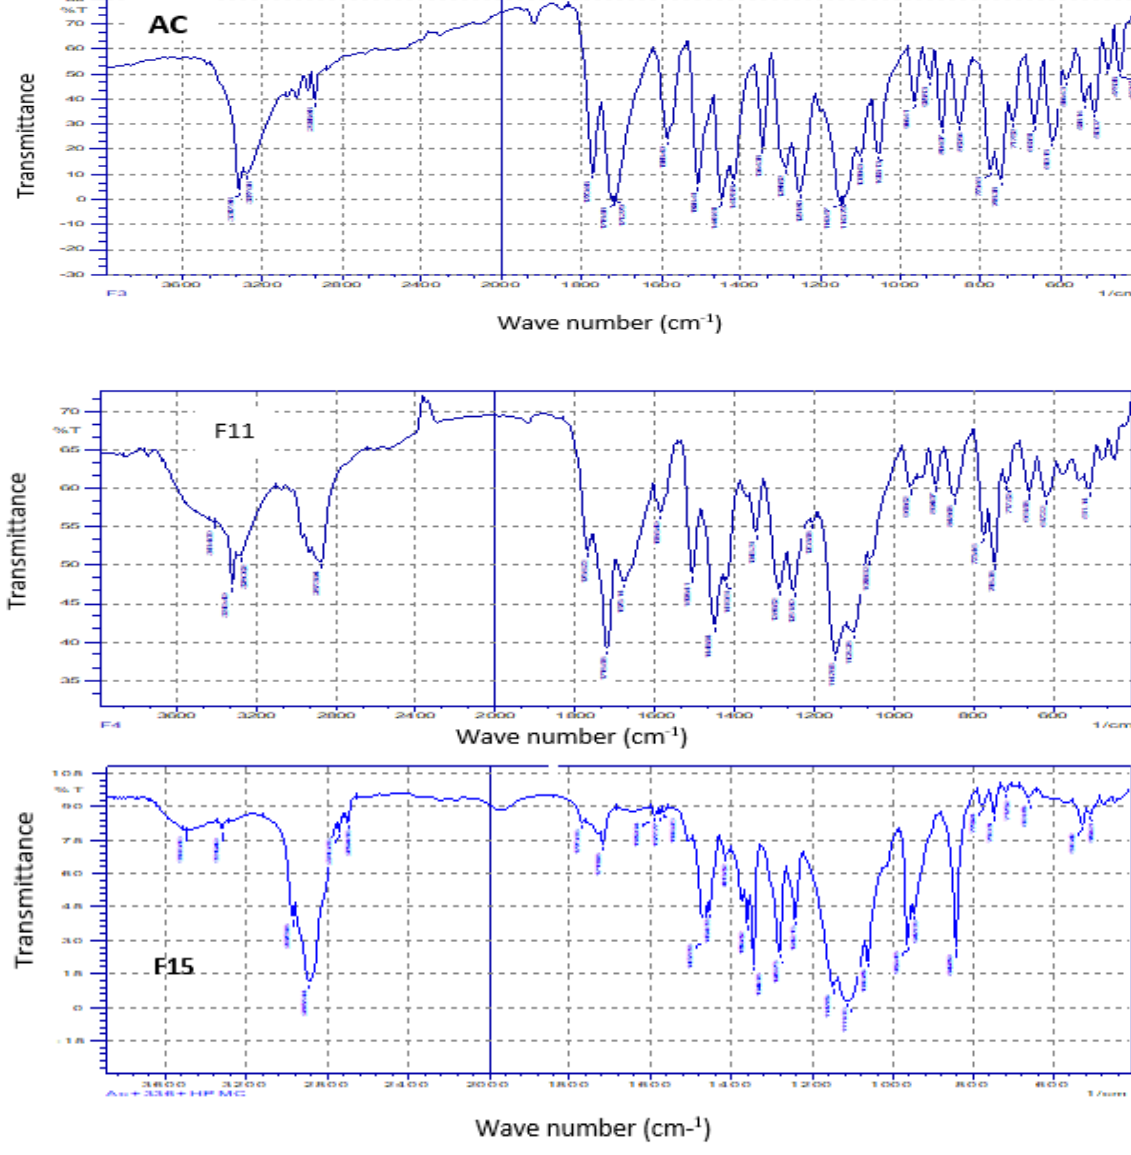
Figure 7. FTIR spectra for pure AC powder, F11 and